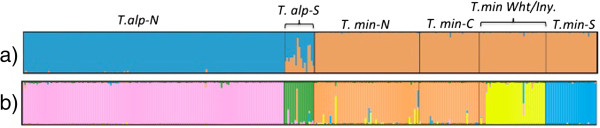
Bayesian analysis of nuclear genetic structure of Tamias populations based on 14 microsatellite loci. Each individual is represented by a vertical line, which is partitioned into colored segments that indicate individual’s membership in (a) 2 or (b) 5 parental populations.